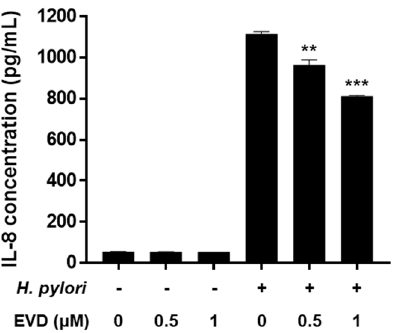
Figure 5. Inhibitory effect of evodiamine on IL-8 secretion induced by H. pylori in AGS cells. AGS cells were uninfected or infected with H. pylori (200 MOI) with indicated concentrations of evodiamine (0.5 and 1 µ M). Culture medium were collected after 24 h and ELISA was performed to determine the IL-8 concentration. Data were presented as mean ± SEM of three independent experiments and analyzed by Student’s t -test (** p < 0.01 and *** p < 0.001). EVD, evodiamine.